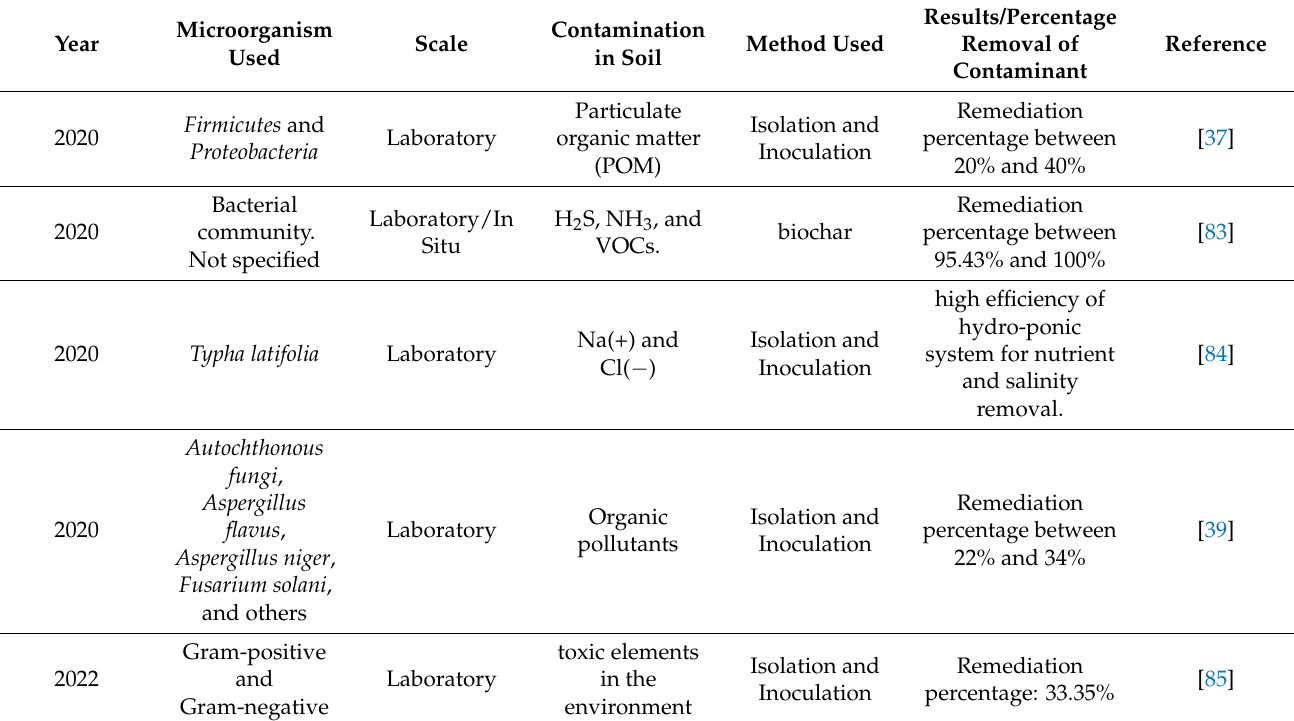
Table 5. The removal rate of Organic pollutants, atmospheric pollutants, and